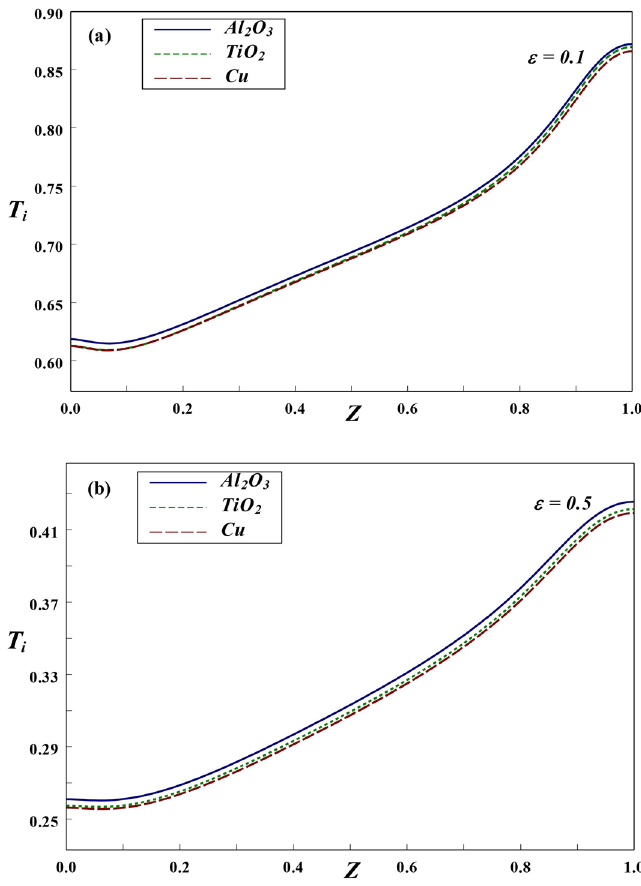
Figure 13. Axial variation of interface temperature with ( a ) ε = 0.1 and ( b ) ε = 0.5